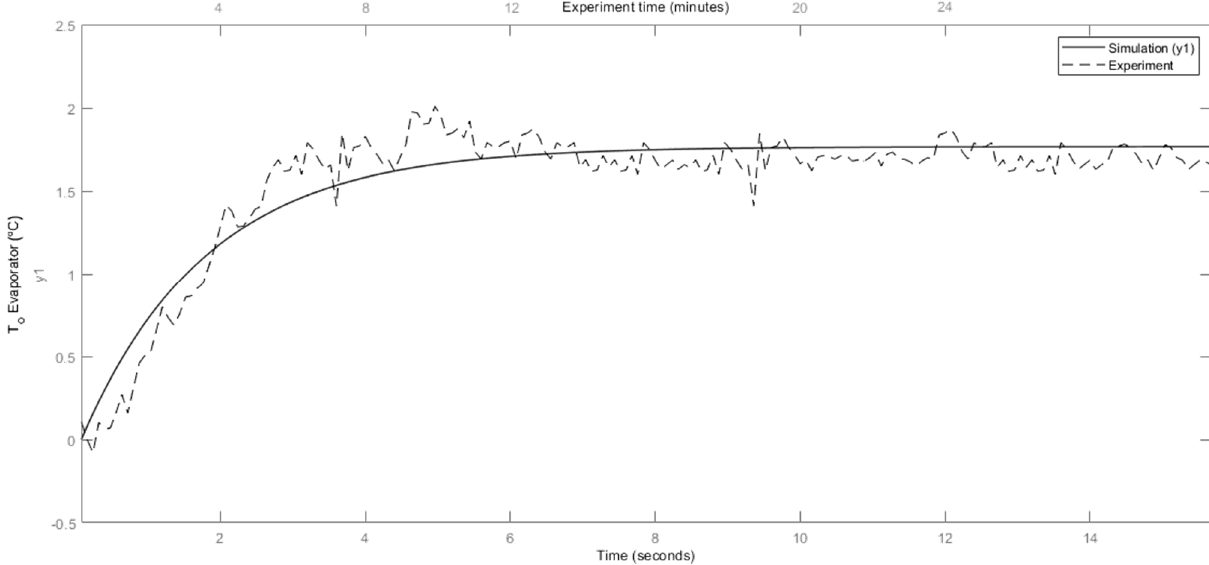
Figure 8. Comparison of temperature response model simulation data (solid line) and experimental data (dashed line).